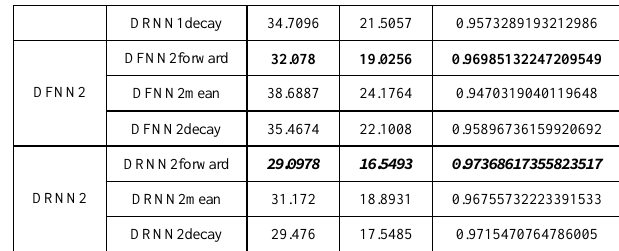
Table 6. Model accuracy of proposed models and baseline models for 1-hour prediction.